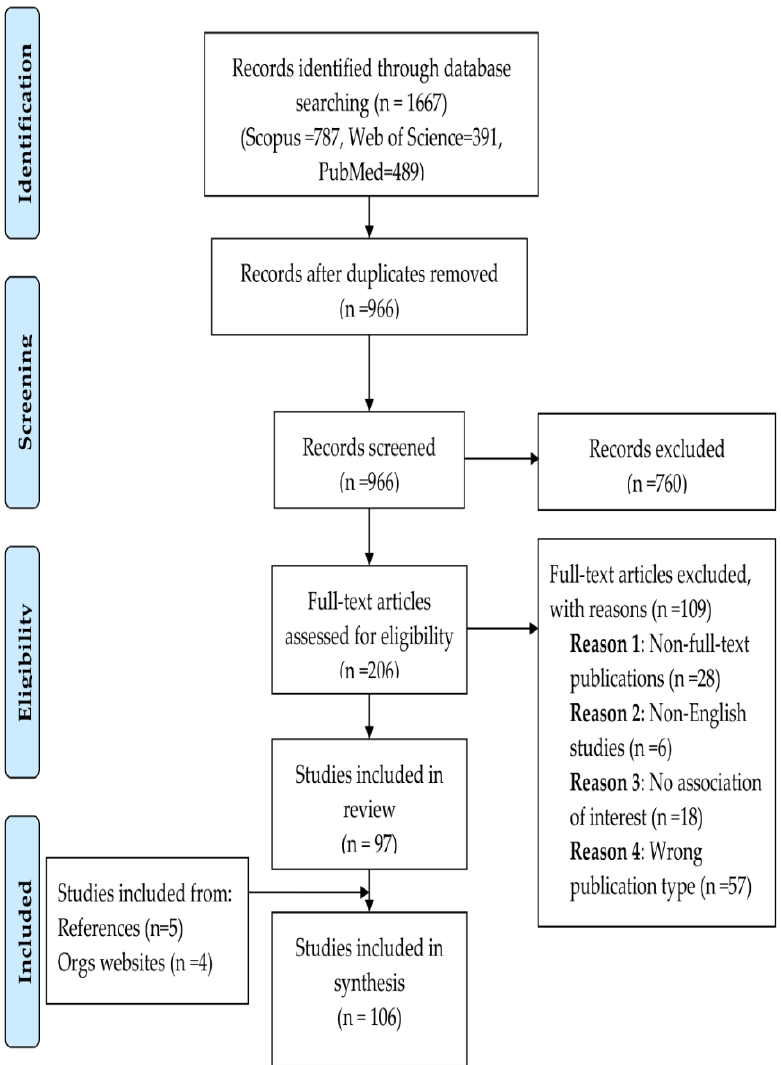
Figure 3. PRISMA flowchart of the results.